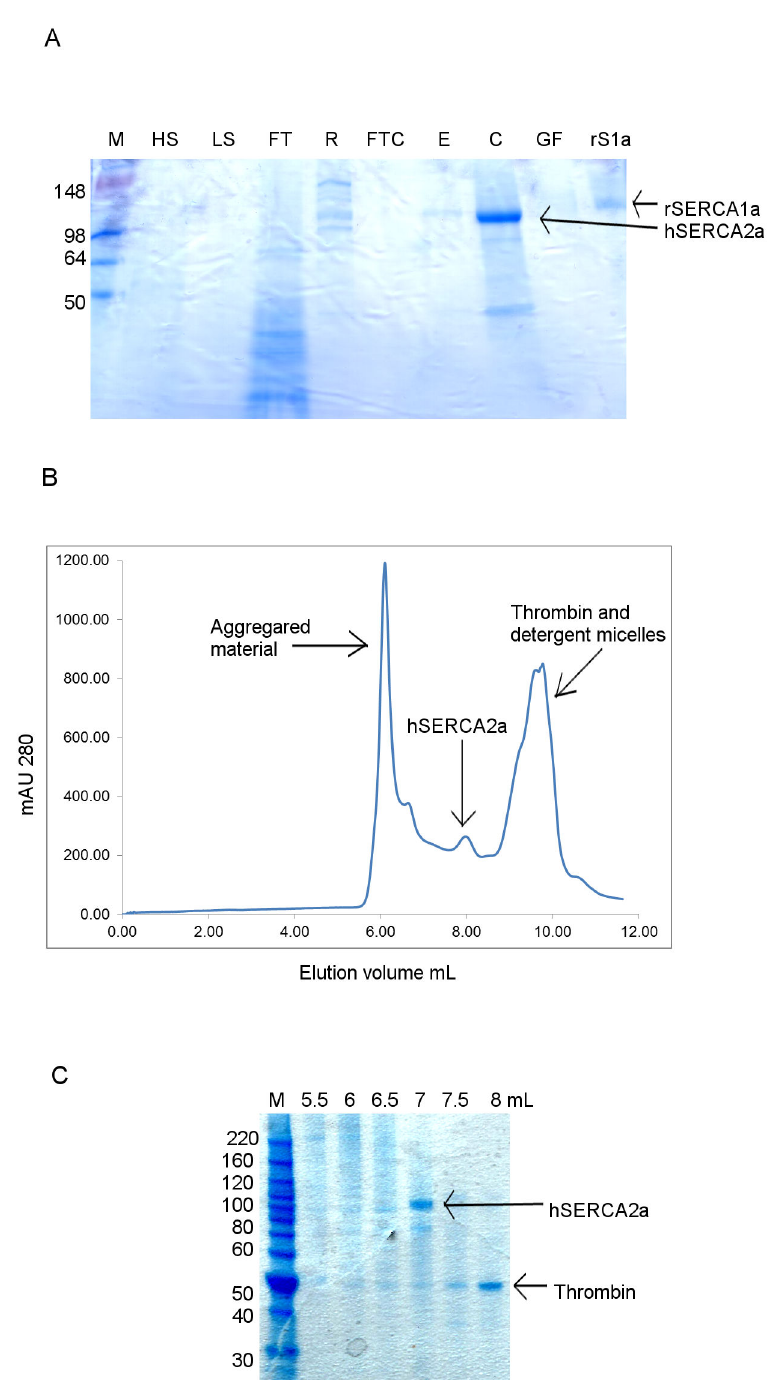
Figure 2. Purification of h SERCA2a-Biotin fusion protein using Streptavidin-Sepharose resin. A . Coomassie stained 12% Tris-Glycine SDS PAGE gel from purification, M- protein ladder, HS-high salt wash, LS-low salt wash, FT- flow-through after binding to Streptavidin resin, R-resin with bound hSERCA2a, FTC- flow-through concentrated, E – elution from Streptavidin resin, C- concentrated sample prior to gel filtration, GF- elution after gel filtration, rS1a- rabbit SERCA1a, 1µg. B . HPLC-SEC profile for hSERCA2a after Streptavidin affinity purification using 12L culture. DDM detergent was exchanged on gel filtration column with C E detergent. C . Coomassie stained 4-12% Bis-Tris SDS PAGE gel. SEC fractions obtained for h SERCA2a purified with 12 8 Streptavidin resin.